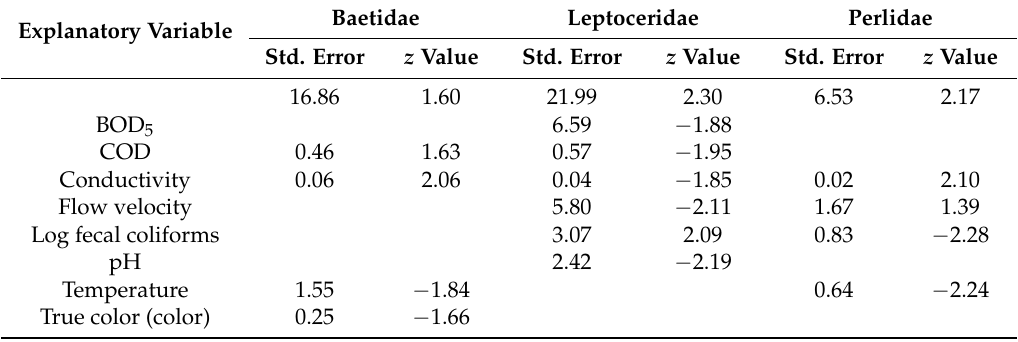
Table A2. Regression parameters: Standard Error and z value of the models for predicting the presence of Baetidae , Leptoceridae and Perlidae .